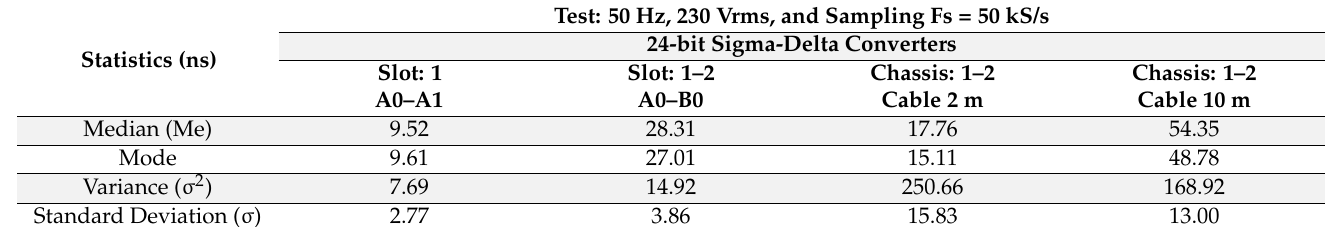
Table 3. Phase errors for Sigma-Delta